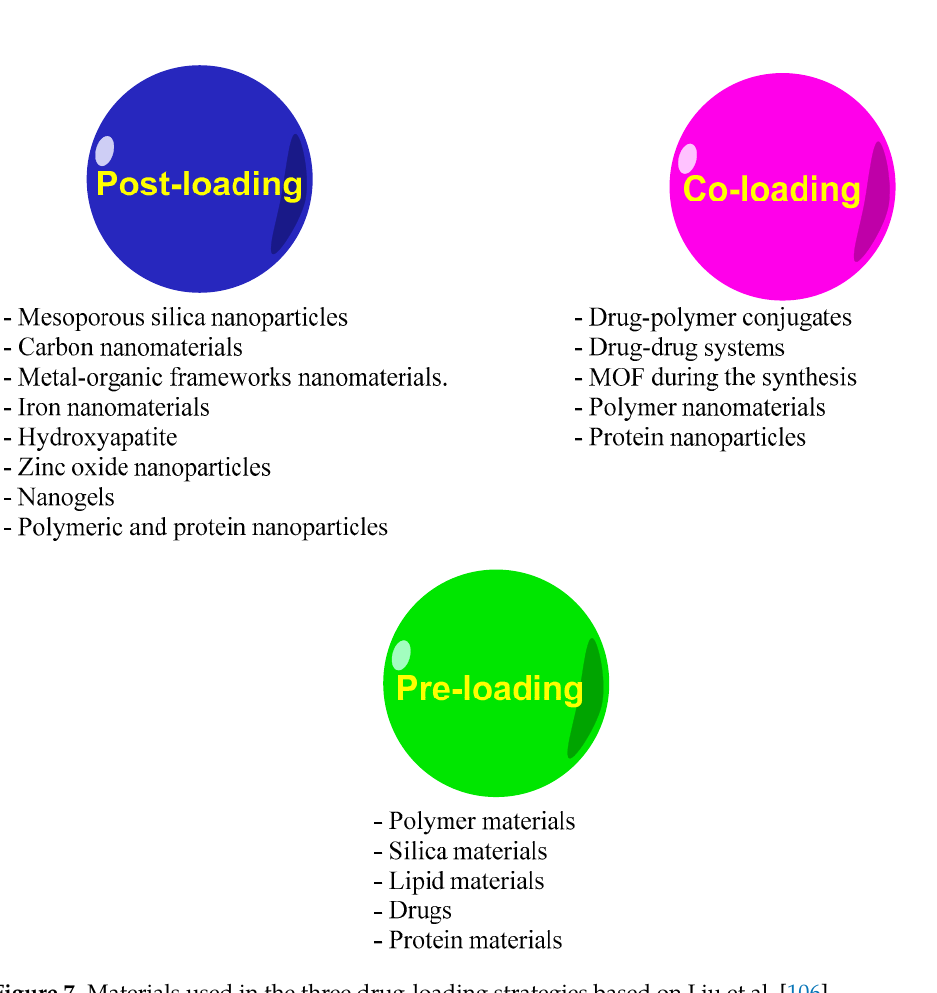
Figure 7. Materials used in the three drug-loading strategies based on Liu et al. [106].